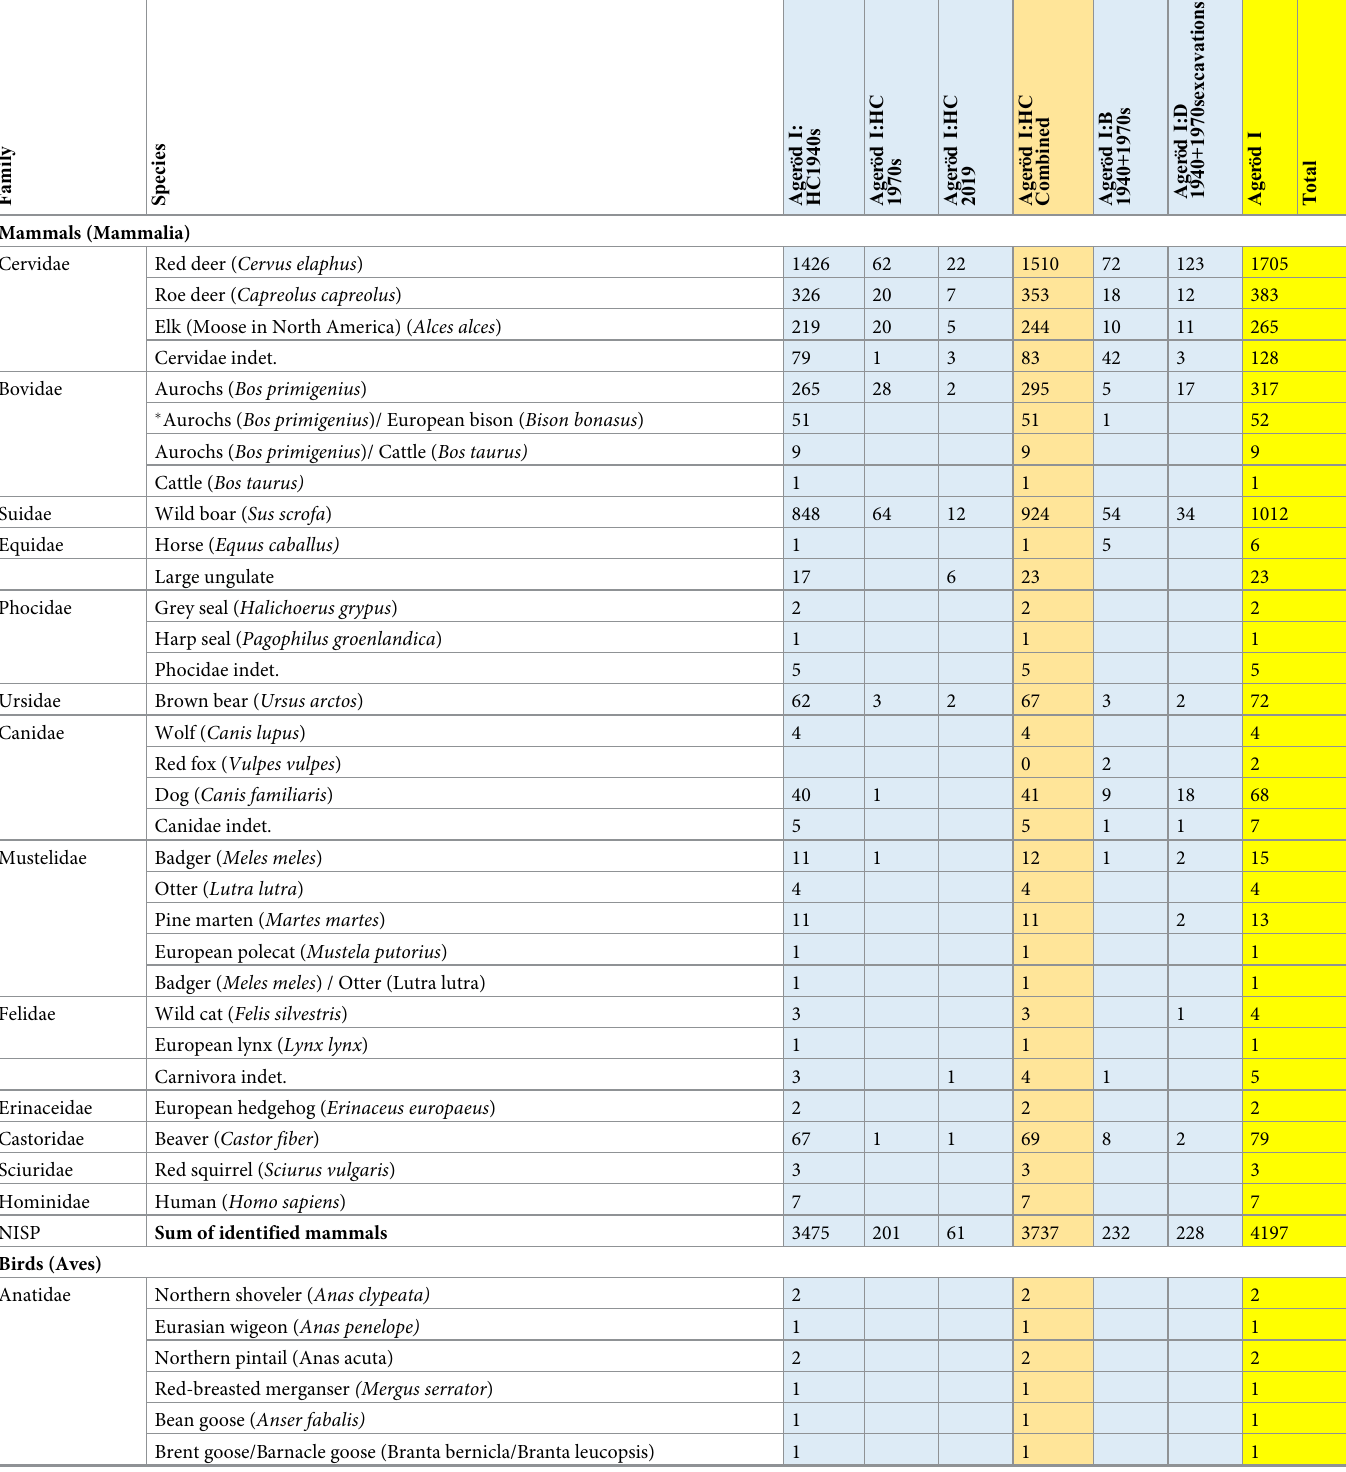
Table 1. Animal species distribution (NISP) from all excavation campaigns at Agero¨d I.